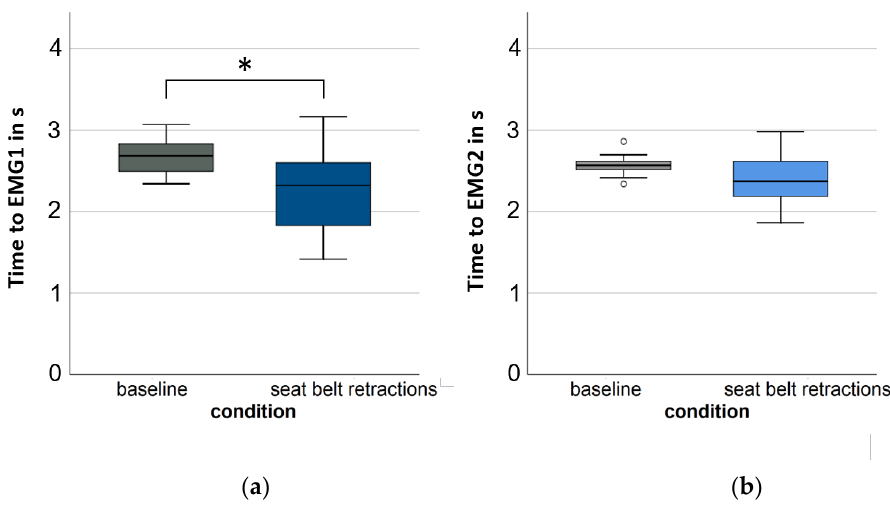
Figure 12. Distribution of time to maximum neck muscle tension in the baseline and with seat belt